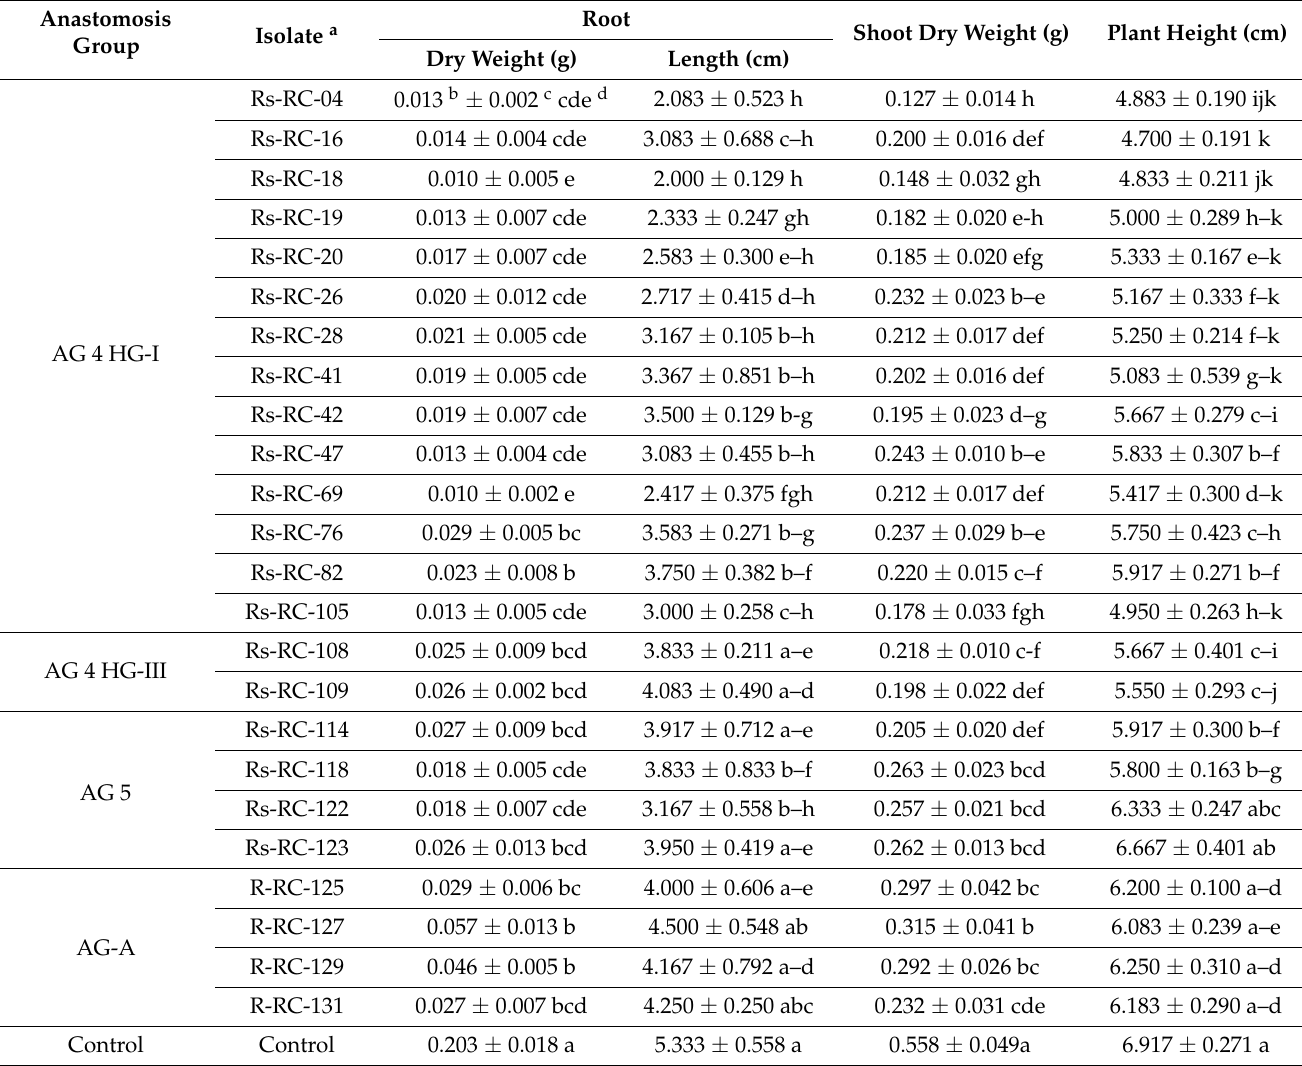
a Rhizoctonia spp. isolates obtained from red cabbage. b Values represent the mean of six replications for each isolate. c Mean values followed by standard error of the mean. d Means in a column followed by the same letter are not significantly different according to Fisher’s LSD test ( p <